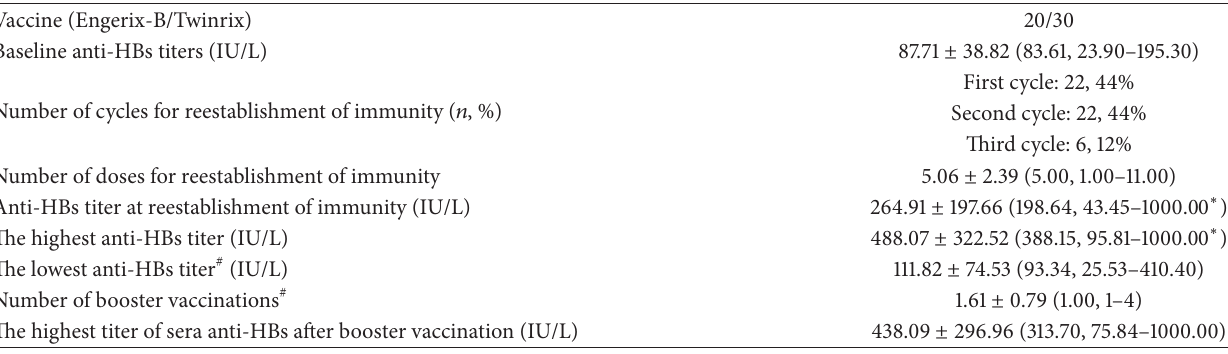
Table 2: Data of the 50 cases at the time active immunity against HBV was reestablished.